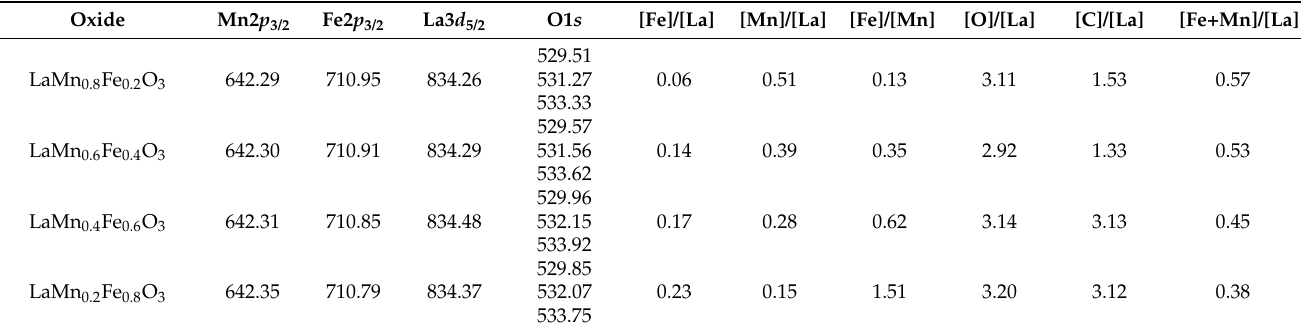
Table 2. Binding energies * of Mn2 p 3/2 , Fe2 p 3/2 , La3 d 5/2 and O1 s (eV) and atomic ratios of elements